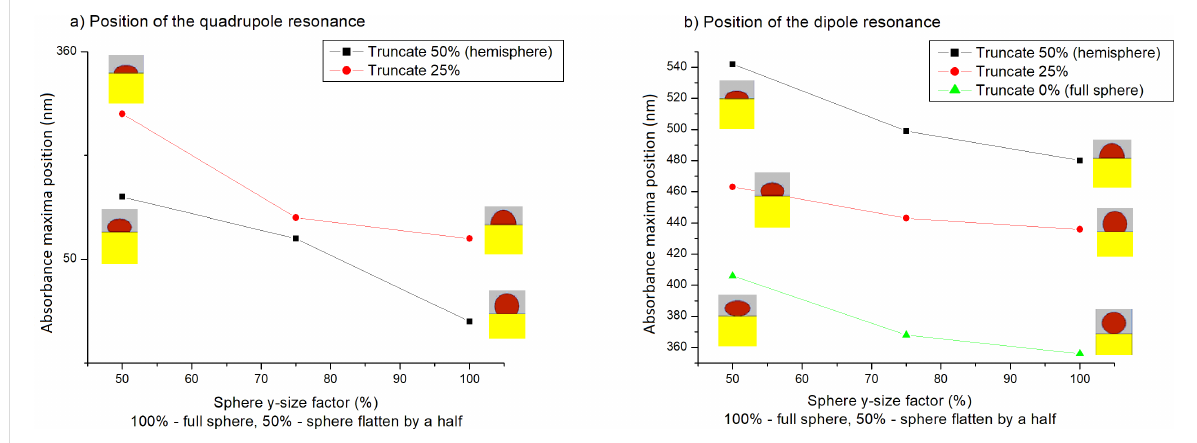
Figure 17: Positions of a) the first and b) the second absorbance maxima (corresponding to the quadrupole and dipole resonance), calculated using FDTD for a single Ag nanoparticle of a size of 100 nm, modeled as a sphere with different truncation and flattening factors on a glass substrate. In the case of a full sphere only dipole resonance